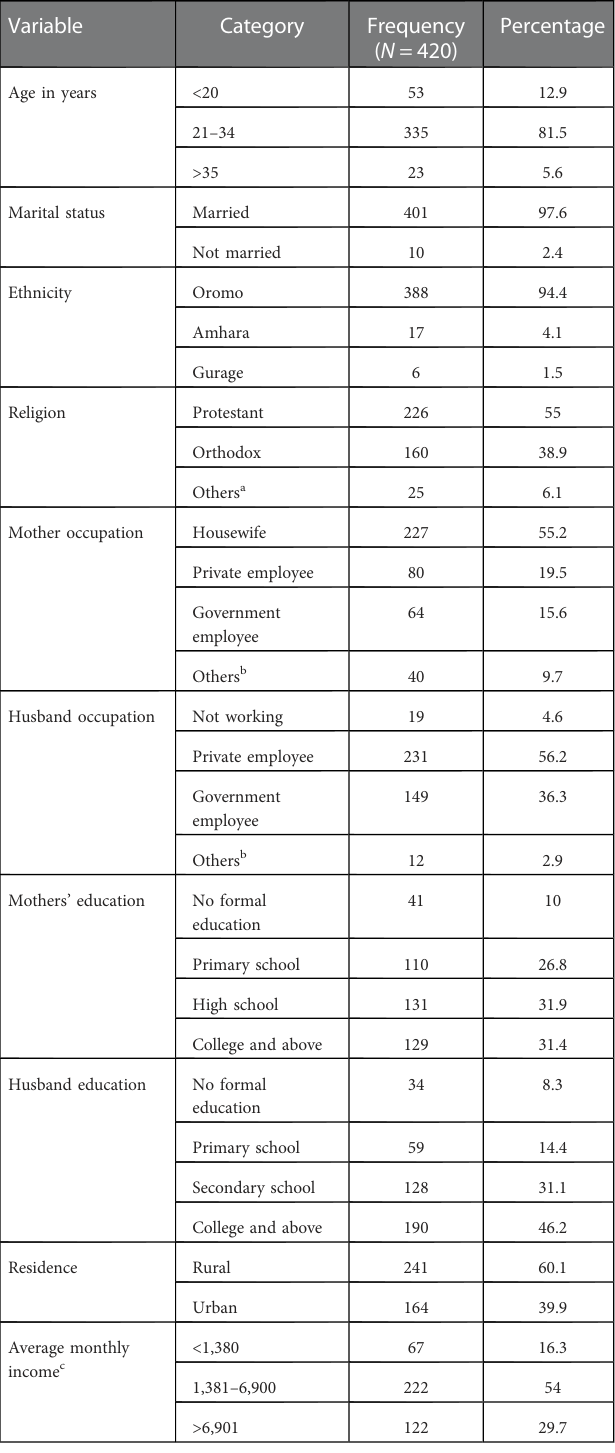
TABLE 1 Socio-demographic characteristics of pregnant women receiving antenatal care at public health facilities in the West Shewa Zone, Central Ethiopia,